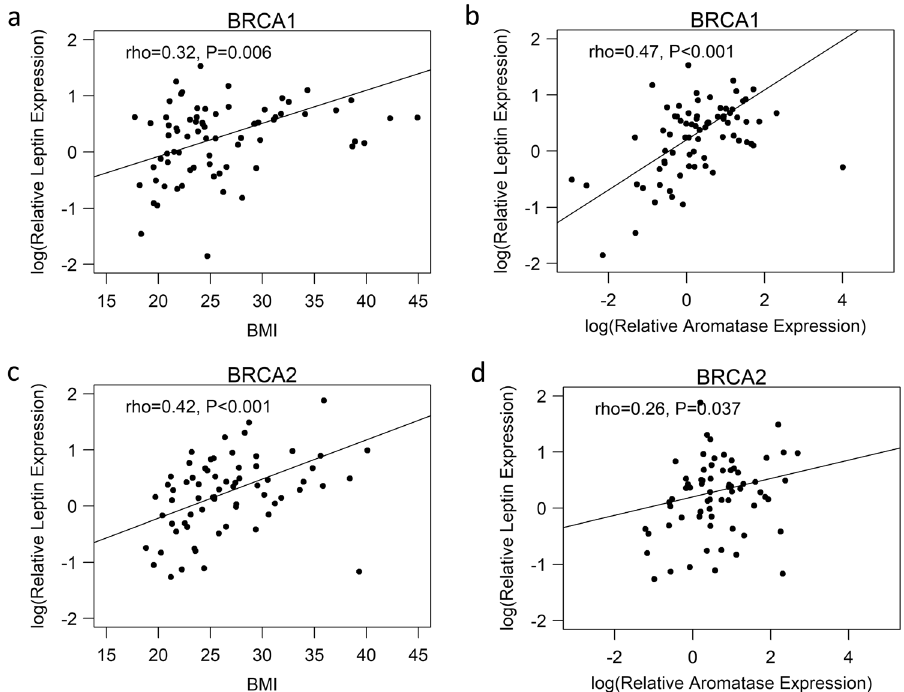
Fig. 3 Breast leptin levels correlate with BMI and aromatase in women with BRCA1 and BRCA2 mutations. a Relative leptin expression by BMI (continuous) in BRCA1 mutation carriers. b Relative leptin expression versus relative aromatase expression in BRCA1 mutation carriers. c Relative leptin expression by BMI (continuous) in BRCA2 mutation carriers. d Relative leptin expression versus relative aromatase expression in BRCA2 mutation carriers.